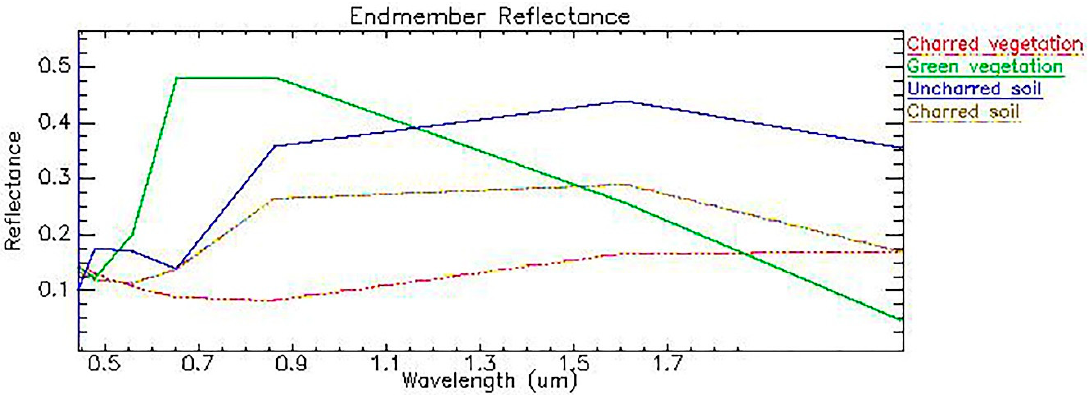
Figure 5. Reflectance spectra from Dark Object Subtraction. Landsat images showing green vegetation and uncharred soil reflectance curves from pre-fire image year 2013 and charred soil and charred/scorched vegetation reflectance curves from post-fire image year 2015.